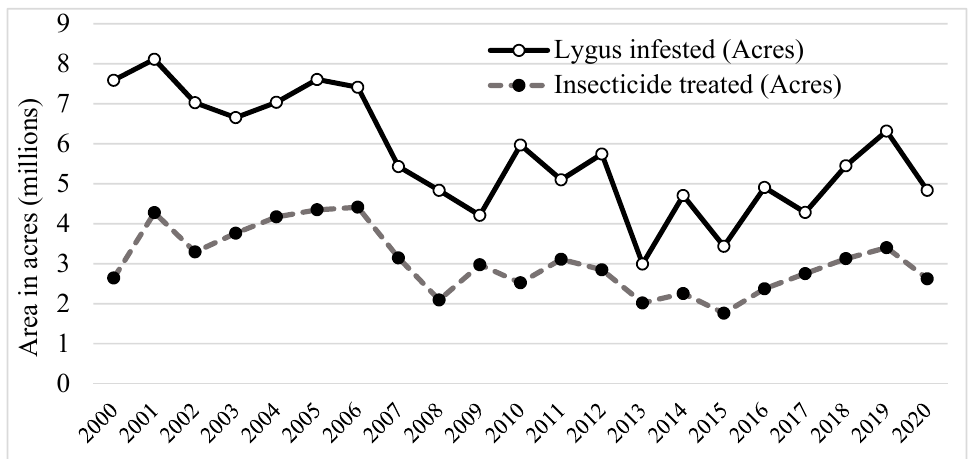
Figure 3. Total Lygus infested acreage and the insecticide treated acreage for Lygus control (millions) in the United States during the last 20 years. Cotton crop loss data https://www.biochemistry.msstate.edu/resources/cottoncrop.php (accessed on 22 June 2021).